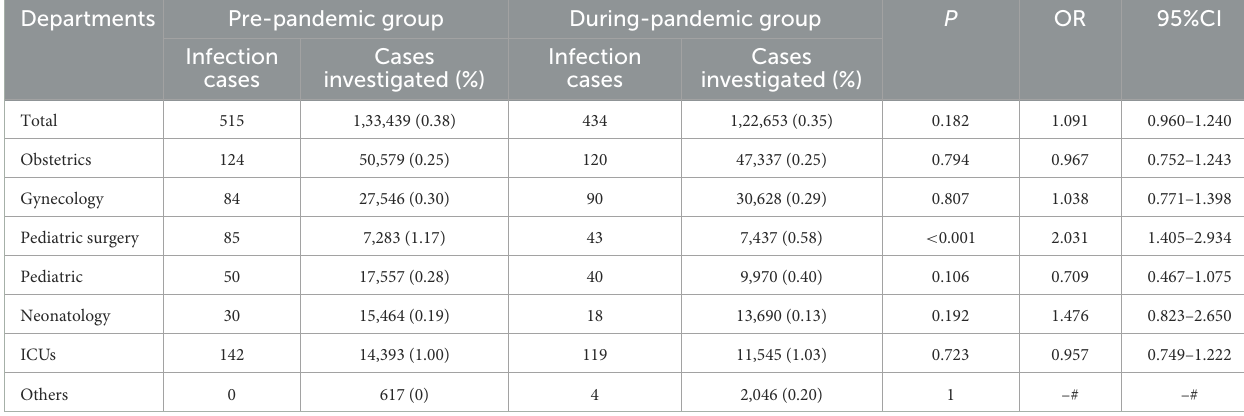
TABLE 3 The prevalence of NIs in different